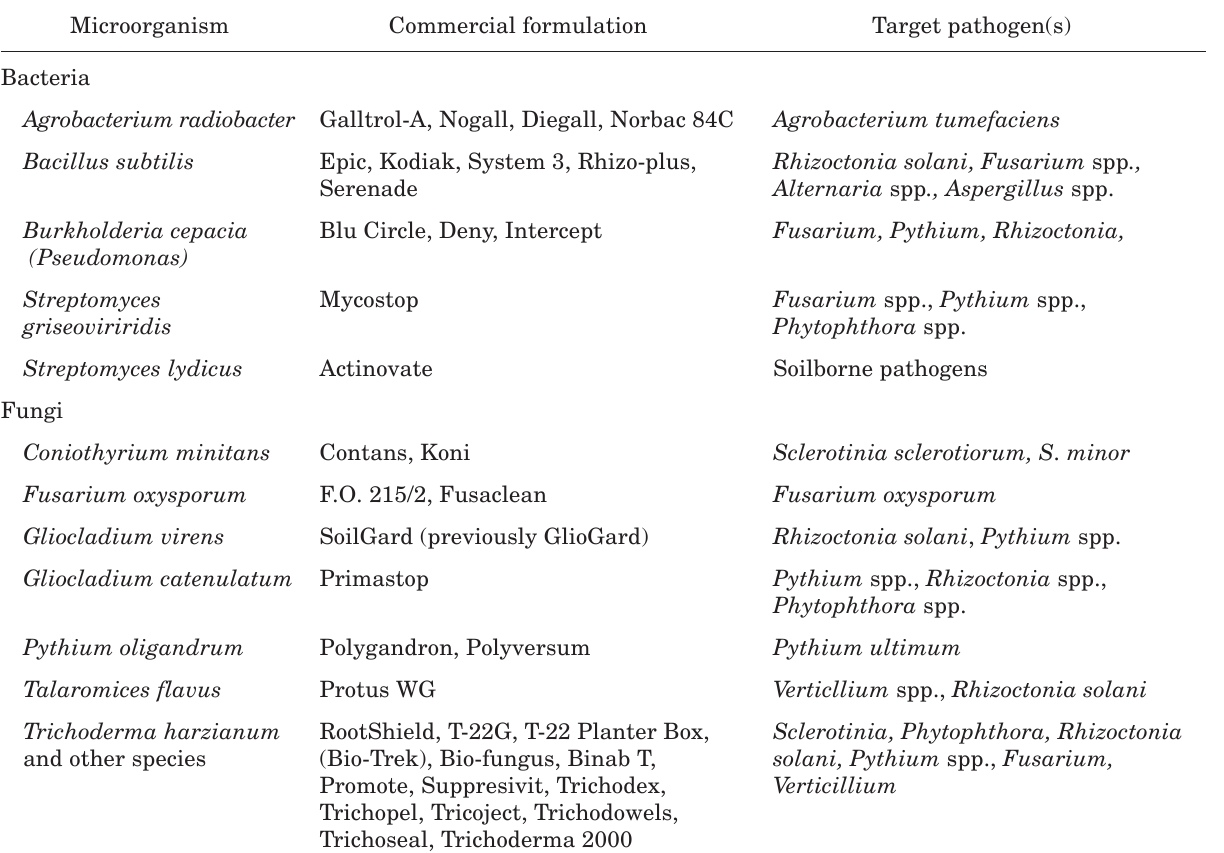
Table 3. Biocontrol agents commercially applied on ornamental crops against soil-borne pathogens in some